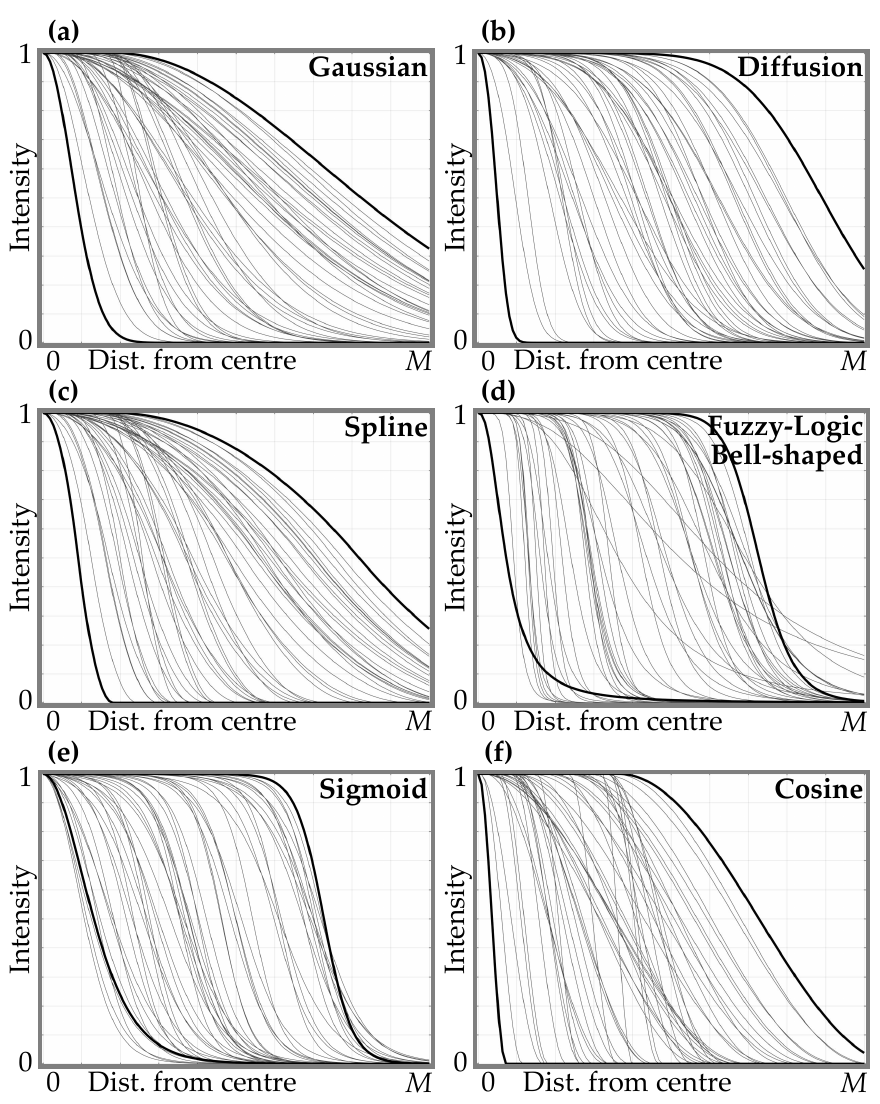
Figure 6. Visualizations of the functions used to create 1D protein spot edge templates. The graph shows the plots of the functions: Gaussian ( a ), simplified diffusion process ( b ), spline ( c ), Fuzzy Logic generalized membership bell-shaped function ( d ), sigmoid ( e ), raised cosine ( f ). The horizontal axis spans the distance from the spot center to the edge of the image sample (in this research, M = 28 px, half of the image patch size, which is 56 × 56 px). The abilities of the functions to imitate the shapes of protein spots are revealed by random sampling parameters from the defined range and plotted as thin lines. Thick lines represent the cases when parameters are being set to the minimum or maximum of the defined range (refer to Table